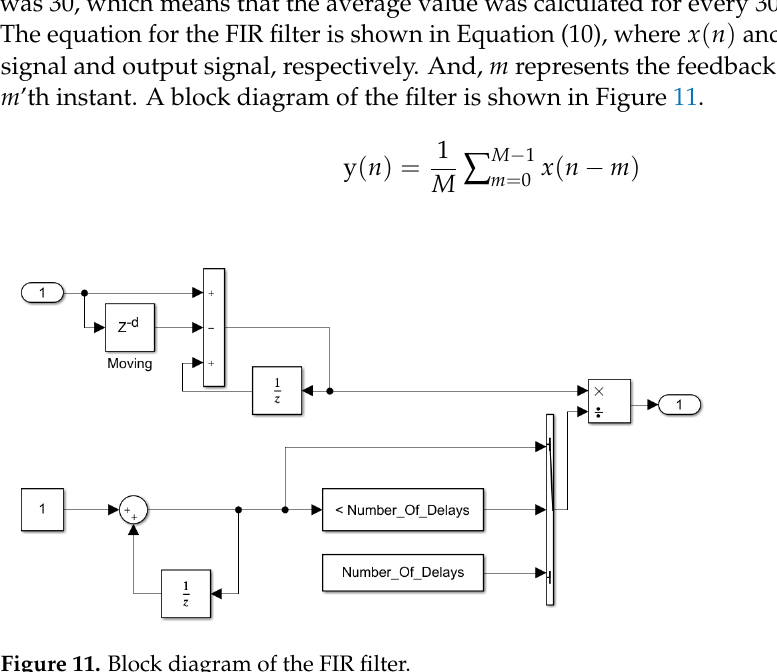
Figure 11. Block diagram of the FIR